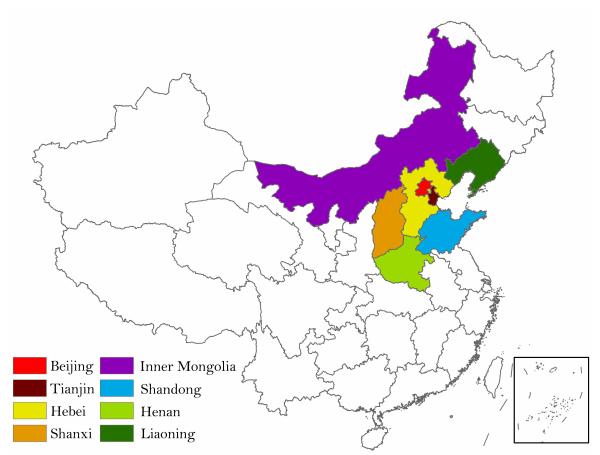
Fig. 1. The larger Huabei region (highlighted in colour) and its location in